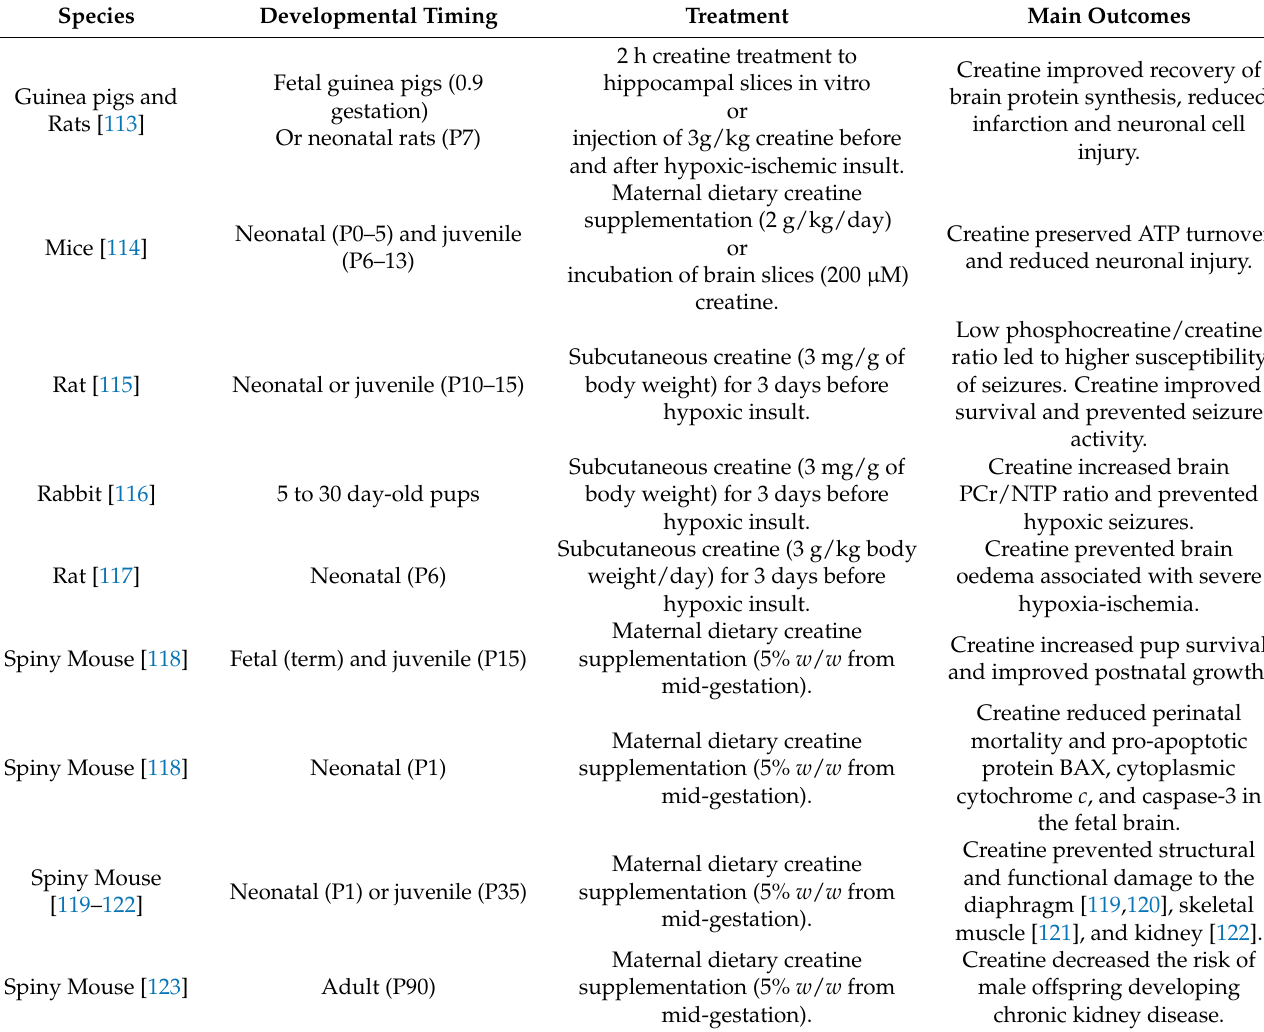
Table 3. Creatine Treatment in Animal Models of Perinatal Brain